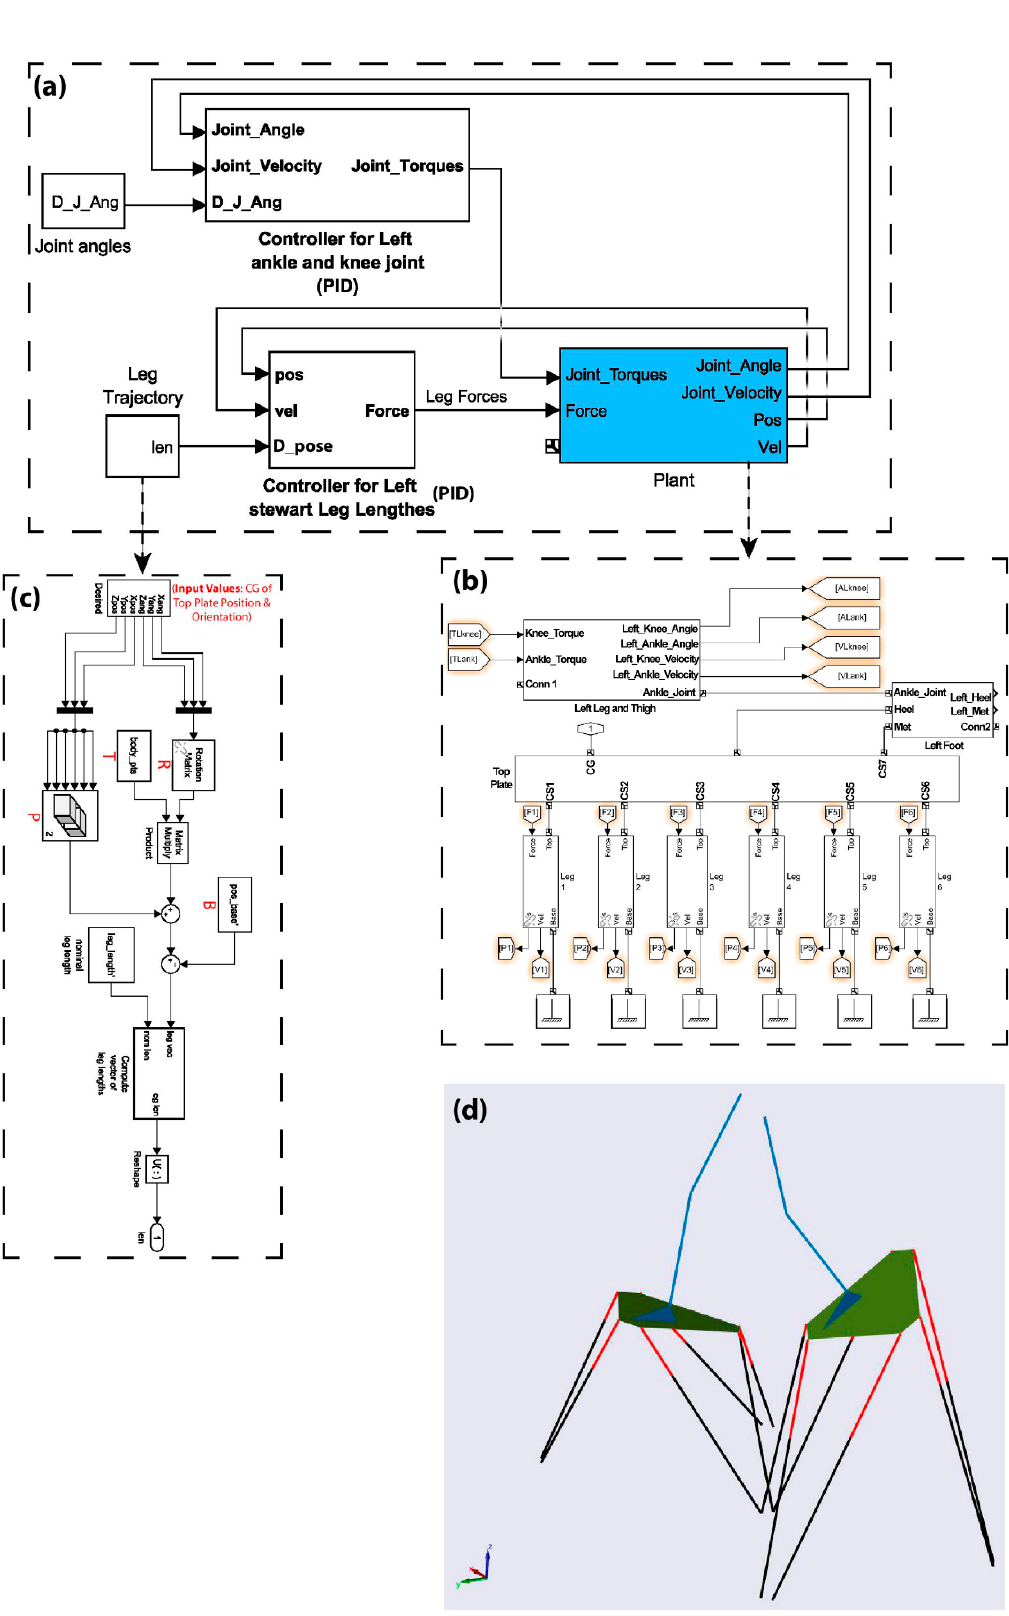
Figure 1. ( a ) The general form of applied blocks in modeling of the system, ( b ) a more detailed plant block, ( c ) the block which transforms top plate positions and angle to Stewart leg lengths, and ( d ) a schematic view of the simulated Stewart platforms and exoskeletons.